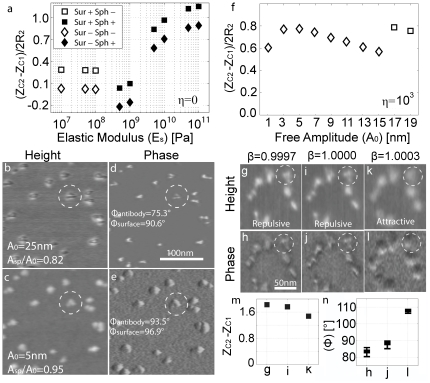
The effects of the elastic modulus and the free amplitude on apparent height.(a) Simulations of the tip-surface and tip-surface-sample interaction. Normalized apparent height (zc2−zc1)/2R2 versus Es. Note that (zc2−zc1)/2R2 might initially decrease with increasing Es. The attractive and repulsive regimes might be reached only on either the surface or the sample. The outcomes of the four possibilities are shown with squares and rhombuses where Sur and Sph stand for surface and sphere respectively. The minus and plus signs refer to the attractive and the repulsive regime. (b) Topography and (c), phase contrast of IgG antibodies on mica where height reversal is observed. The attractive regime is stably reached on the surface whereas the repulsive regime is immediately reached where any topography occurs (e.g. the antibodies). This phenomenon leads to the high contrast in phase compared to where the attractive regime (d–e) is reached both on surface and the antibodies. (f) Simulations of the tip-surface and tip-surface-sample interaction. An extra viscoelastic component (η) has been added to the contact region (see Figs. S3, S4, S5, S6 in the supplementary for details). Normalized apparent height (zc2−zc1)/2R2 versus A0 for Asp/A0 = 0.88. The attractive regime is reached both on the surface and the sphere for the lower values of A0 and (zc2−zc1)/2R2 initially increases and then decreases with A0. For larger values of A0 the repulsive regime is reached on the surface only and (zc2−zc1)/2R2 increases. (g–l) Topography and phase images of IgG antibodies with different normalized driving frequencies (β = f/fr) and constant A0 and Asp. Here (zc2−zc1)/2R2 increases in the repulsive regime. The respective values for height and phase are shown in (m–n). Simulation parameters: (a) A0 = 12 nm, Asp/A0 = 0.70, E = 1 GPa, γ = 50 mJ/m2 and H = 10×10−20 J; (f) Asp/A0 = 0.88, E = 10 GPa, Es = 0.1 GPa η = 1000 and the rest as above. Experimental parameters: (b–e) as detailed in the figures; (g–l) A0 = 24 nm and Asp/A0 = 0.7.